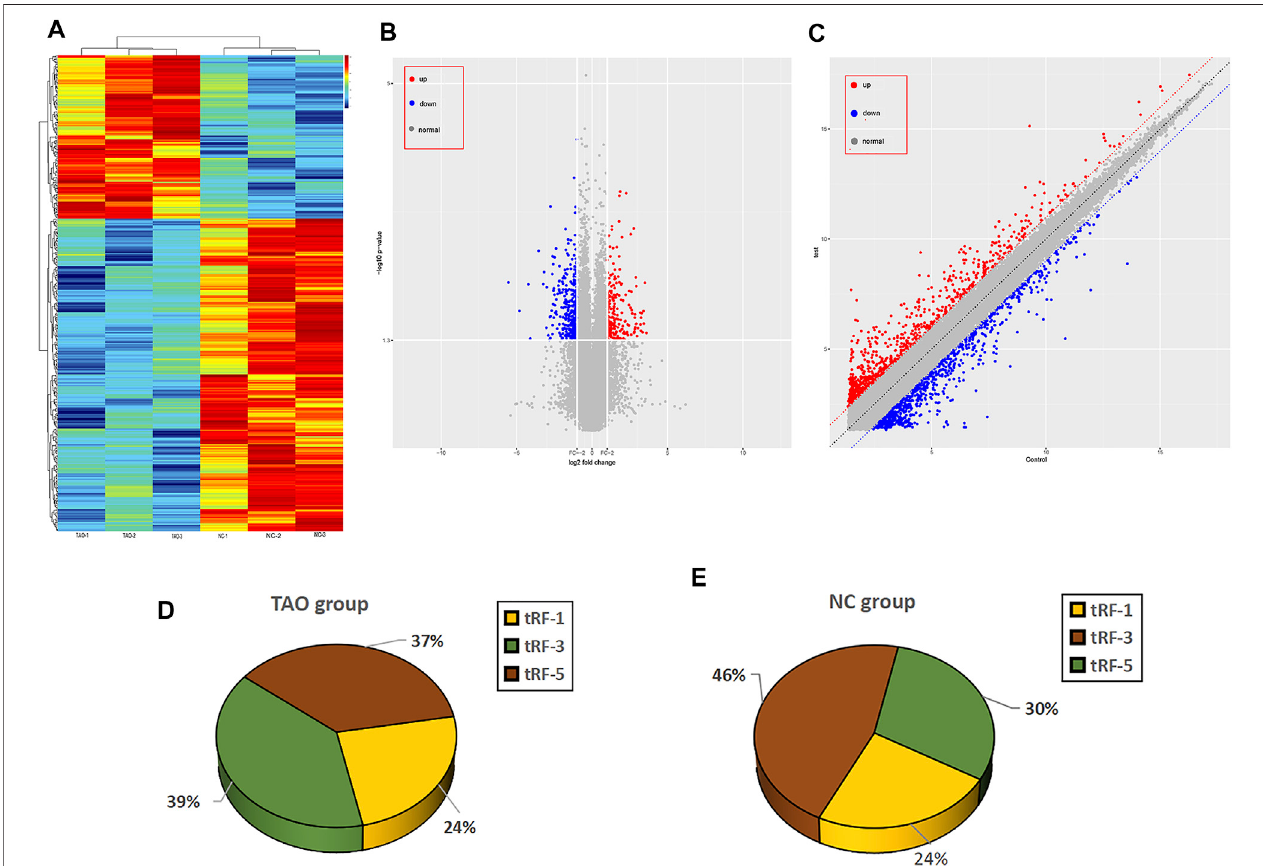
FIGURE 1 | Overview ofthe expression pro fi les of mRNA and tRNA-related fragment sequencing data in paired TAO patients versus the normal control group. (A) Hierarchical clustering heatmap analysis of the mRNA sequencing data of the paired TAO group and the normal group. The abscissa of the main image is the sample name, and the samples are sorted (grouped) according to the calculated distance; the ordinate is the gene symbol. (B) The volcano plot presents differential expression between the groups. Red dots indicate upregulated genes, blue dots indicate downregulated genes, and gray dots indicate genes with no signi fi cant differences. (C) Scatter plot between the two groups. Red dots indicate upregulated genes, and blue dots indicate downregulated genes; gray dots represent genes with no signi fi cant differences. (D) Pie charts for all tRFs of each group using all uniquely expressed tRFs. The expression level percentage of each subtype of tRF in the TAO group is shown in the pie chart. (E) The expression level percentage of each subtype of tRF in the control group is shown in the pie chart.